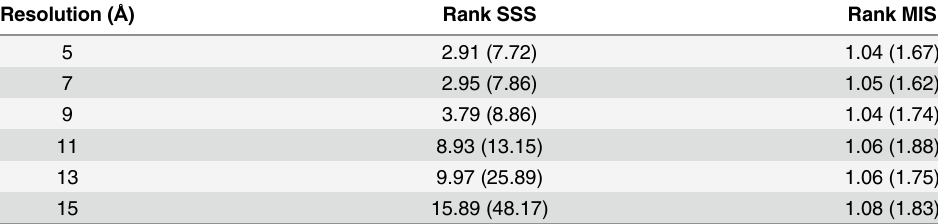
Table 3. Average rank of best RMSD result returned by PF 2 fit — SE(3) after reranking. In the initial stage GCCS was used. The figures in brackets denote the rank in the presence of noise at SNR = 1. We see a strong decrease in rank for the skeleton-secondary structure score with and without noise while the mutual information score remains predictable across the range of resolutions. See the section on “ Datasets ” for a list of PDBs used to generate the synthetic maps used in this experiment. Note that even if the ranks of the best RMSD solution, on average across all experments, show no improvement over Table 1 (mostly because GCCS already does an excellent job of ranking them)- the ranks actually improved for several of the experi- ments (73/318 for MIS, and 5/318 for MIS). Please see Section ‘ The performance of reranking increases with resolution ’ for